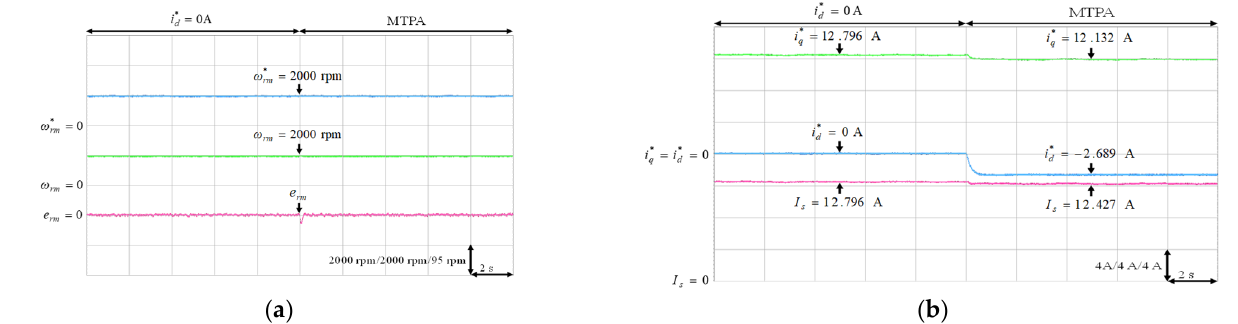
Figure 15. Experimental results of MTPA control at 2000 rpm with 9.5 Nm: ( a ) mechanical speed command, speed and speed error; ( b ) q -axis current command, d -axis current command and stator current. Table 3. Training errors of PPFNN-AMF.